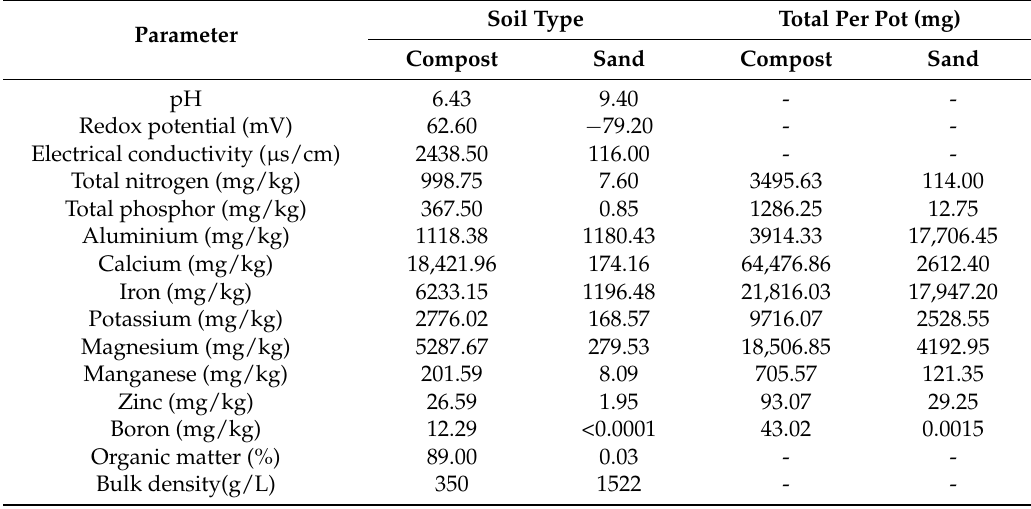
Table 3. Basic soil properties based on three replicates each (14 September 2013).